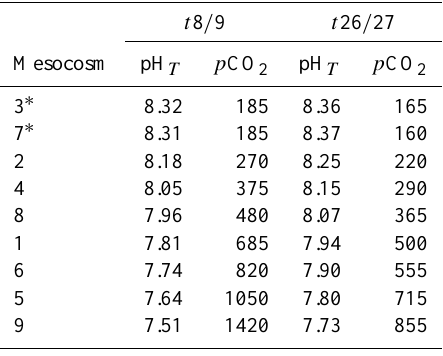
Table 1. Average pH T and approximate p CO 2 levels (µatm) on t 8 / 9 and t 26 / 27 during the experiment (Bellerby et al.,